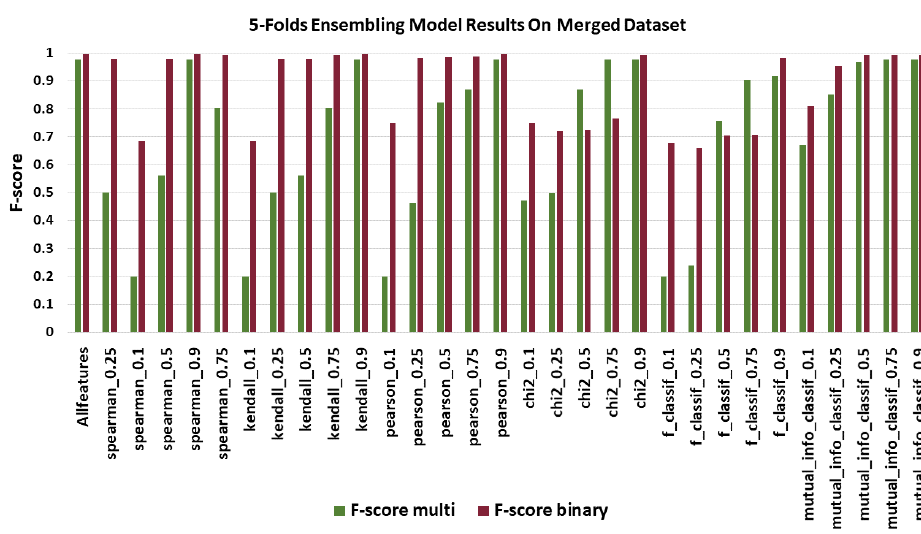
Figure 5. F1-scores using merged